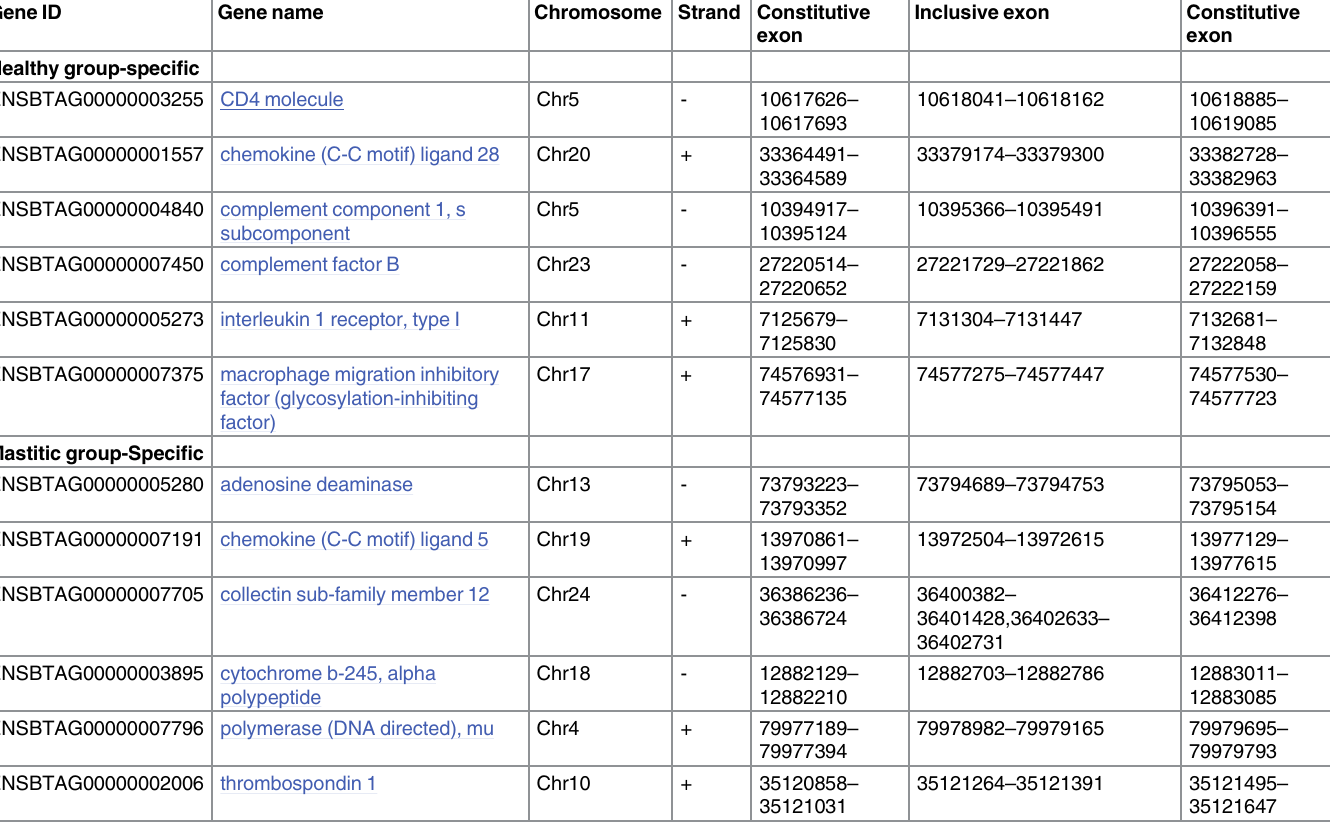
Table 3. Genes with exon skipping events were health-specific and mastitis-specific and participated in immune, defense and inflammatory